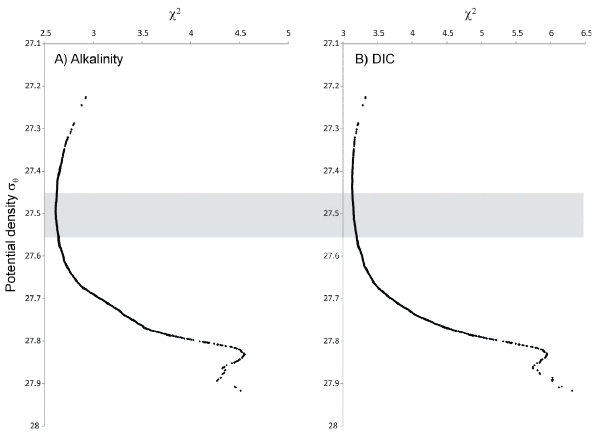
Fig. 3. Chi square ( χ 2 ) of the best fit for all the data from the Monte Carlo (5000 iterations) run on potential density surfaces ( σ θ ). (A) alkalinity data, (B) DIC data. σ θ = 27 . 5 was chosen as the optimal breakpoint as it has a minimum χ 2 for both alkalinity and DIC. The area shaded in grey is the overlap ( σ θ = 27 . 5 ± 0 . 05) where both algorithms are used and the value is